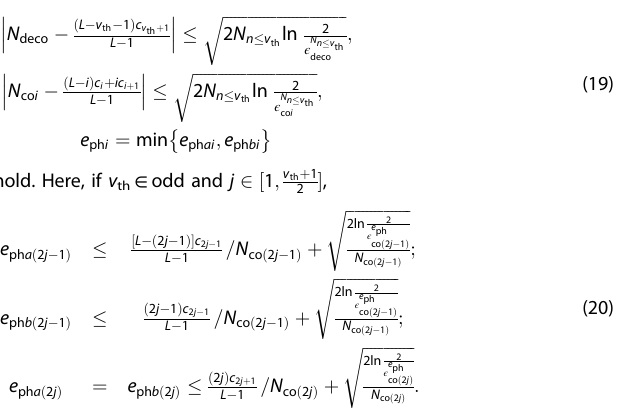
ffiffiffiffiffiffiffiffiffiffiffiffiffiffiffi q 3 e src ln 1 e , where μ represents the N em ϵ